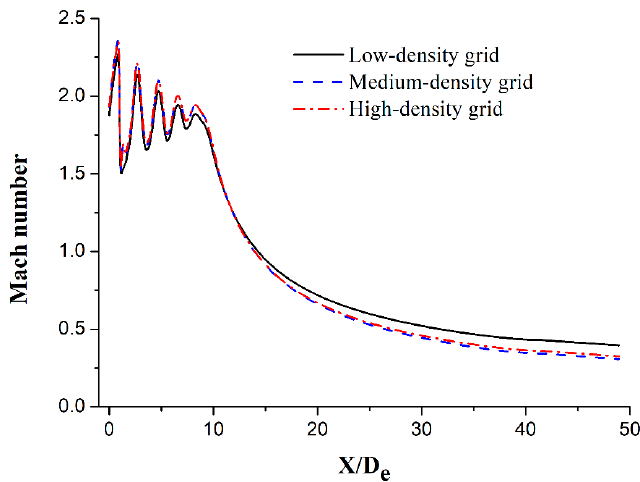
Figure 4. Axial Mach number of the main oxygen jet for different grid levels.